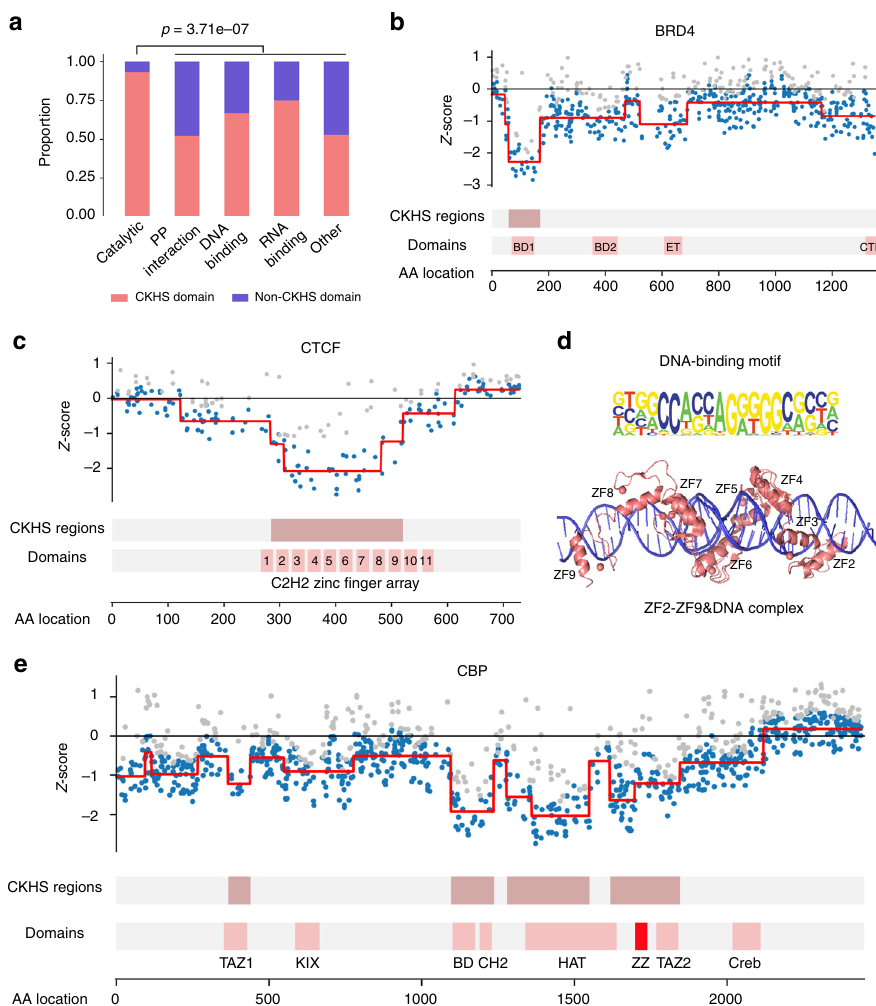
Fig. 3 The CKHS pro fi les of multi-domain proteins. a All the domains in 51 multi-domain proteins were categorized based on their molecular functions. The bar chart shows the proportion of CKHS-overlapped domains for each category. The p -value was computed based on hypergeometric distribution. b The CKHS pro fi le and domain annotation of BRD4. c The CKHS pro fi le and domain annotation of CTCF. d The 3D structure of CTCF (ZF2-ZF9) complexed with DNA (PDB IDs: 5UND;5T0U). The DNA-binding motif 48 is aligned with the structure. e The CKHS pro fi le and domain annotation of CBP. The ZZ domain is highlighted in